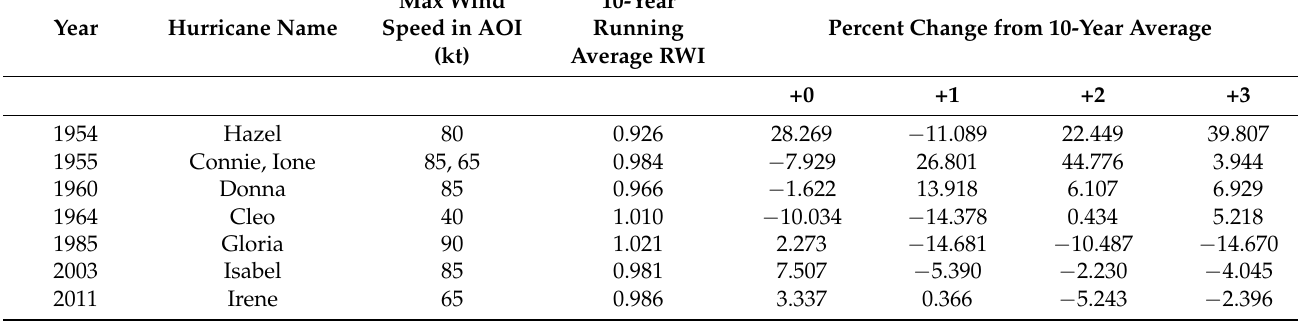
Table 1. Descriptive information for five major named hurricanes within the AOI, 20 nautical miles (37 km) of ARNWR during the study period (1895–2018), and an additional three of regional importance [37,51,56]. Maximum Sustained Windspeed in knots (kt) is reported. Percent Change is the deviation from 10-year running average of RWI prior to the current year. Lags are in the current year, one, two, and three years post-hurricane, all contrasting the same 10-year period for each hurricane.